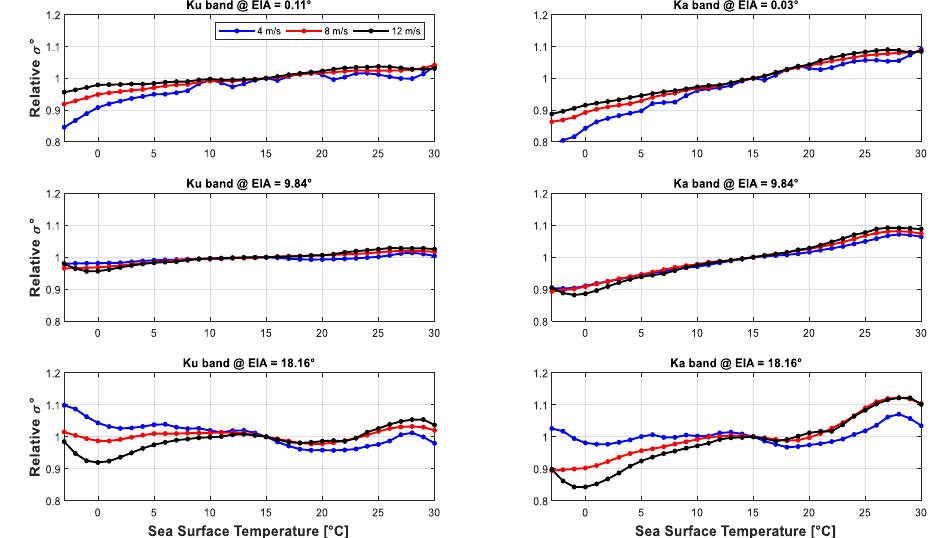
Figure 21. Wind speed impacts on KuPR and KaPR σ 0 SST dependency at different EIAs.